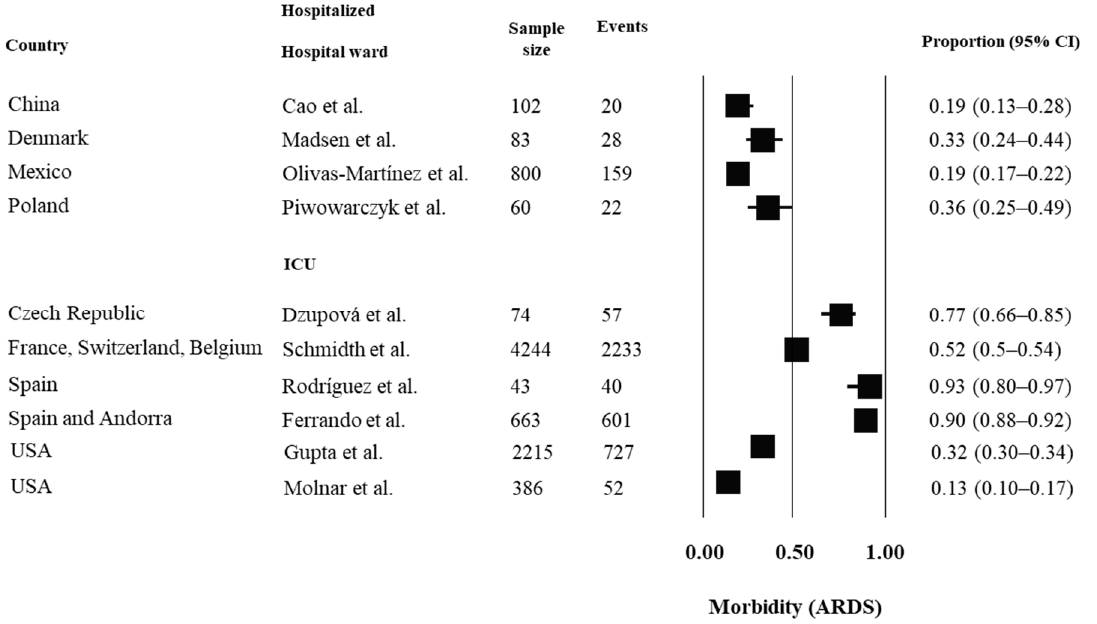
Figure 3. Prognosis of morbidity, considering ARDS, in hospitalized people with COVID-19. For analysis, the studies were grouped by country and by hospital setting (hospital ward or ICU). Estimates of proportions for dichotomous data, considering the number of events and sample size, were reported. Abbreviations: ARDS = acute respiratory distress syndrome; USA = United States of America; IC = confidence interval. References: Cao et al. [15]; Madsen et al. [17]; Olivas-Martínez et al. [23]; Piwowarczyk et al. [25]; Dzupová et al. [28]; Schmidth et al. [29]; Rodríguez et al. [35]; Ferrando et al. [38]; Gupta et al. [41]; Molnar et al. [42].